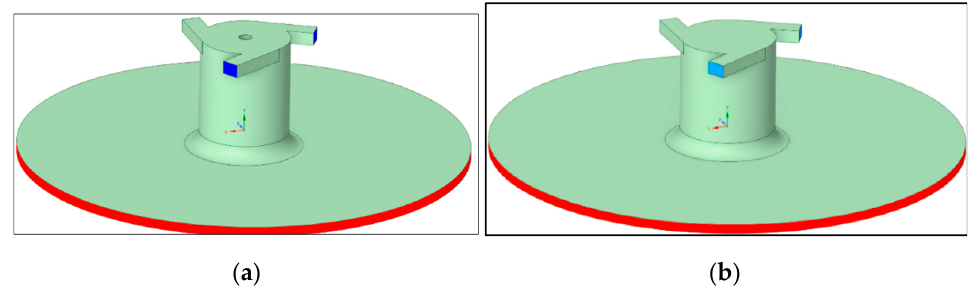
Figure 1. Model of investigated SVT ( a ) with the inner body (case 1) and ( b ) without the inner body (case 2).